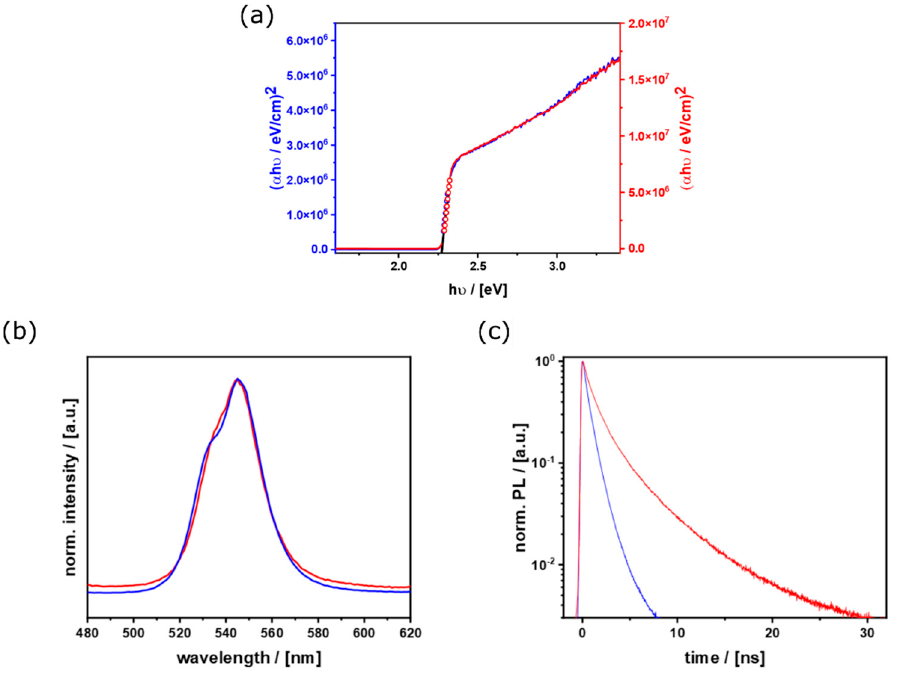
Figure 6. Results from ensemble measurements: ( a ) Tauc plots from UV/Vis absorption data for CU (red) and RD (blue) particles fitted and calculated bandgap of 2.27 eV for both morphologies; ( b ) PL emission spectra and (c) time resolved PL decays for both morphologies (blue: RD, red: CU).